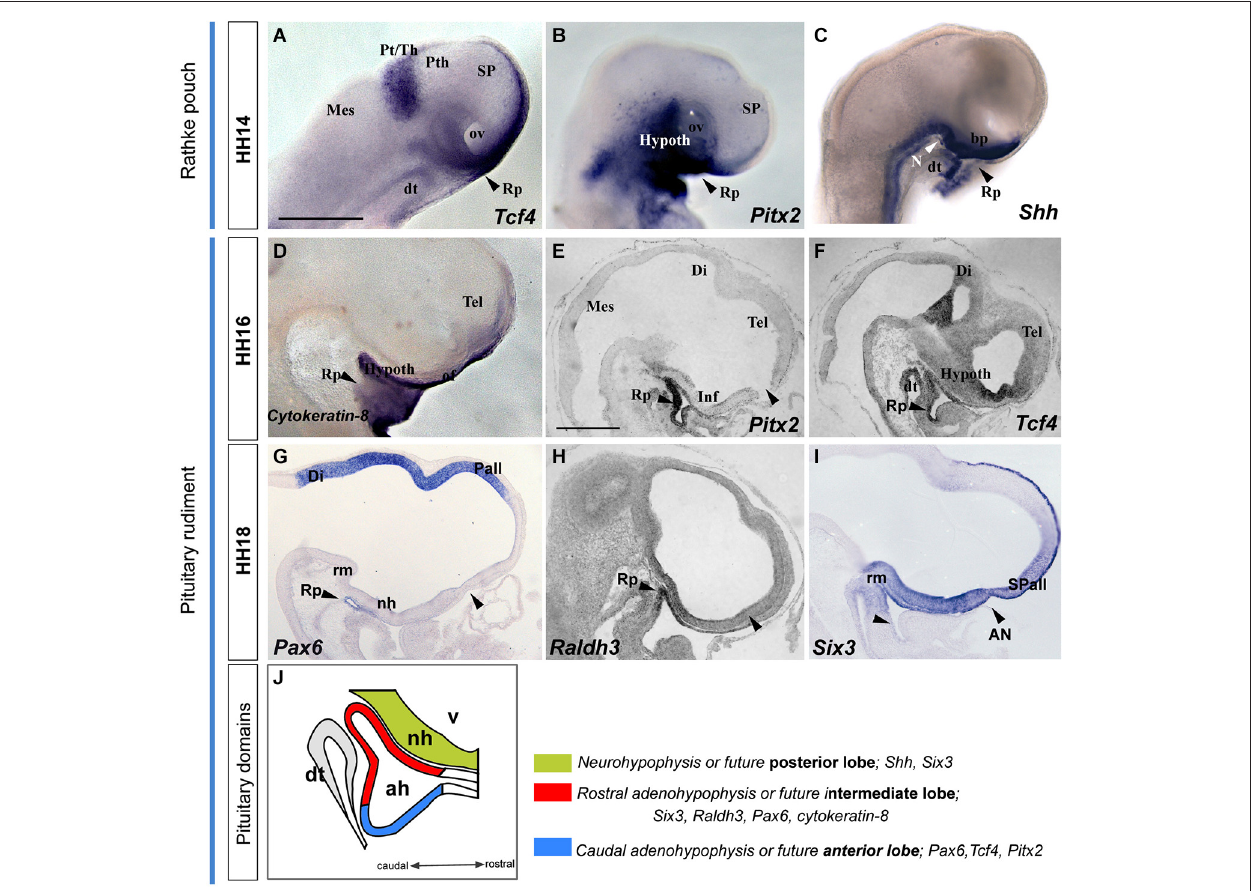
embryos for Tcf4, Pitx2, Shh , Cytoqueratin-8, Pax6, Raldh3 and Six3 . (J) The schema represents the pituitary rudiment and its initial molecular subdivision. Scale bar: 250 µ